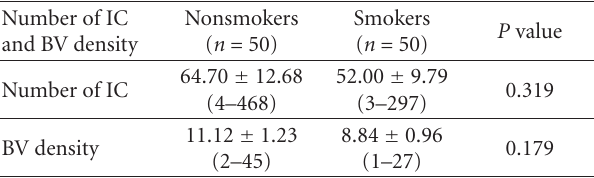
Table 10: Comparison of number of IC and BV density between nonsmokers and smokers. Results are presented in Mean ± SD